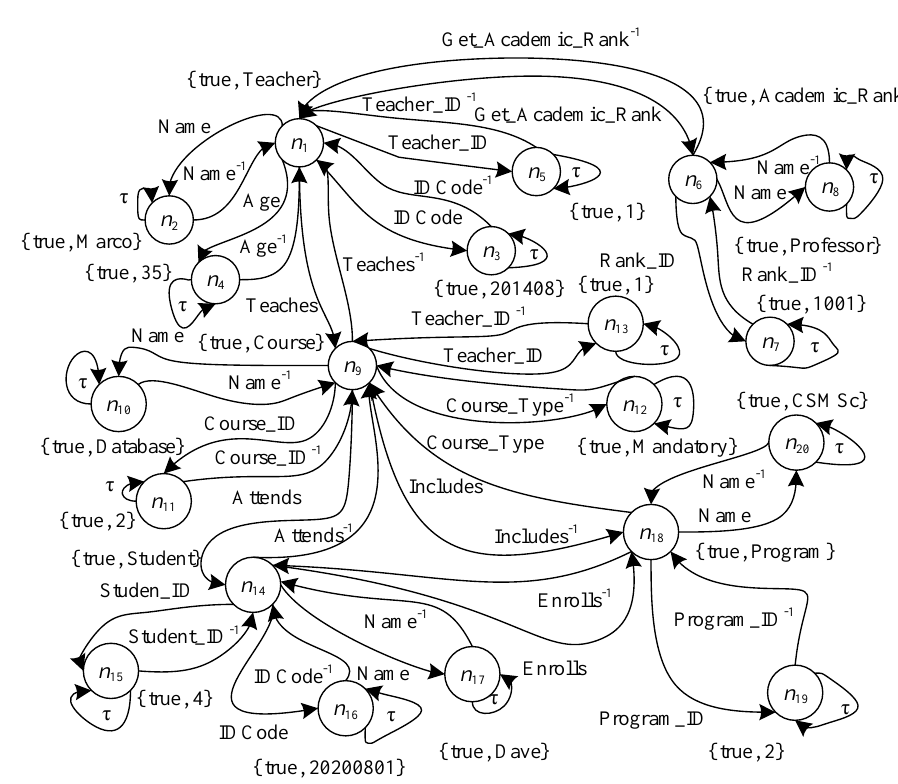
Figure 4. Kripke structure of Mini University data